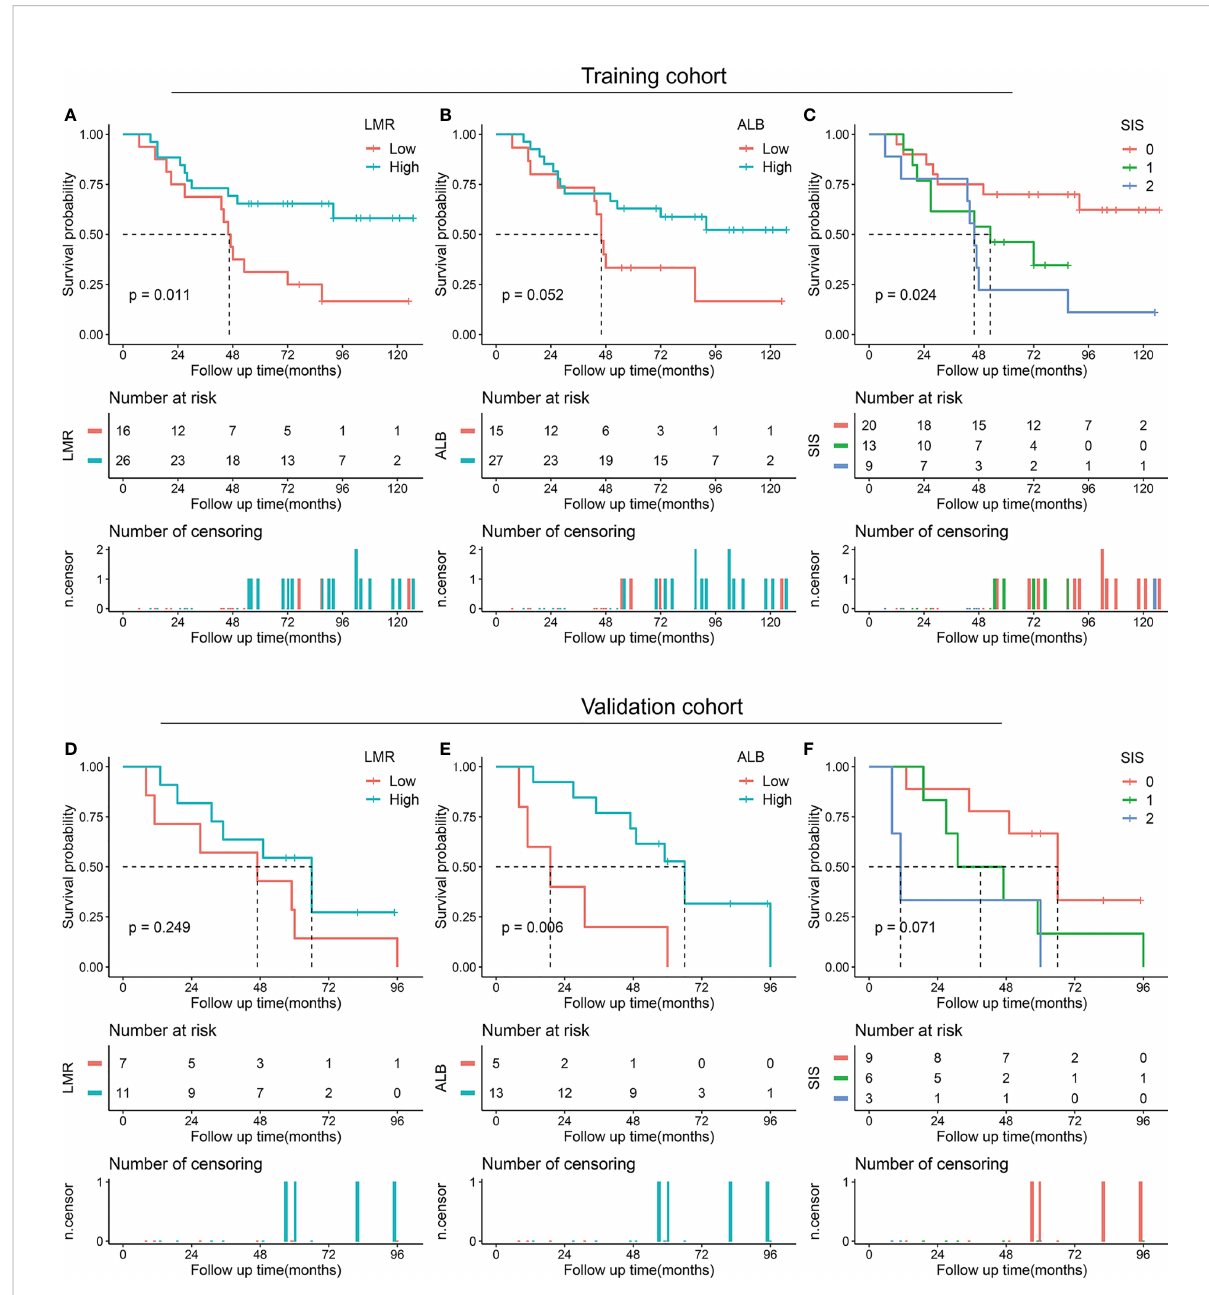
FIGURE 4 Kaplan-Meier survival analysis of LMR, ALB, and SIS in skull base chordoma with partial resection. (A) OS analysis of LMR in the training cohort. (B) OS analysis of ALB in the training cohort. (C) OS analysis of SIS in the training cohort. (D) OS analysis of LMR in the validation cohort. (E) OS analysis of ALB in the validation cohort. (F) OS analysis of SIS in the validation cohort. LMR, lymphocyte to monocyte ratio; ALB, albumin; SIS, systemic in fl ammation score; OS, overall